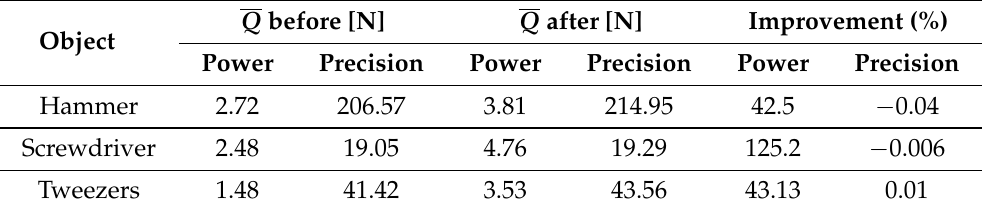
Table 6. Grasp quality improvement with and without assisting